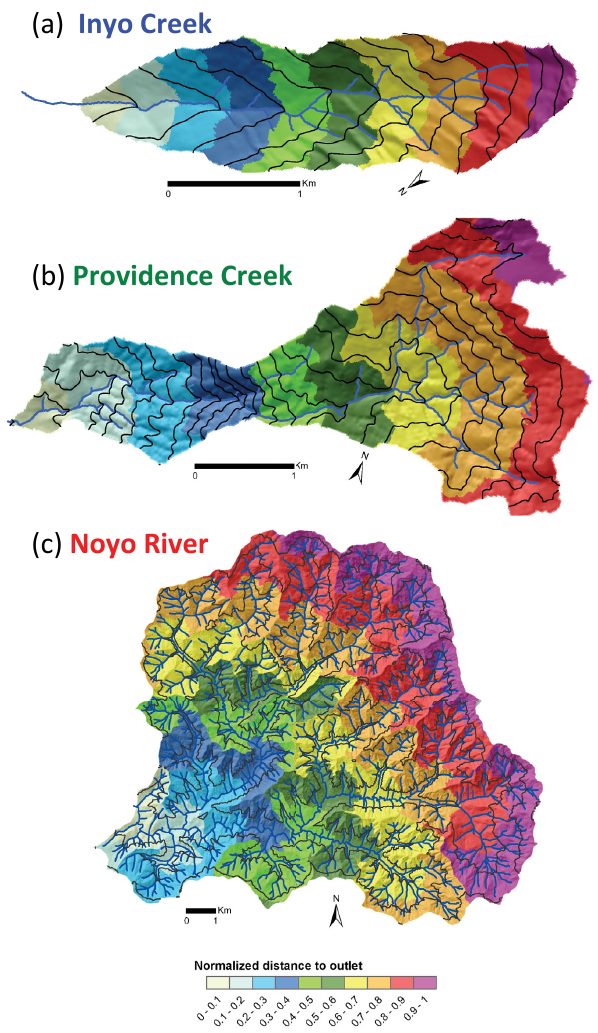
Figure 2. Spatial distributions of elevation and travel distance. Maps showing the spatial distribution of elevation and travel dis- tance across the Inyo Creek (a) , Providence Creek (b) , and Noyo River (c) study catchments. Black lines are elevation contours, with hillshade in background for emphasis. Color shade shows scaled values of travel distance (normalized by the maximum value in the catchment). Note variation in scale and compass orientation from one watershed to the next. Elevation contour spacing is 50m in (c) and (b) and 200m in (c) .